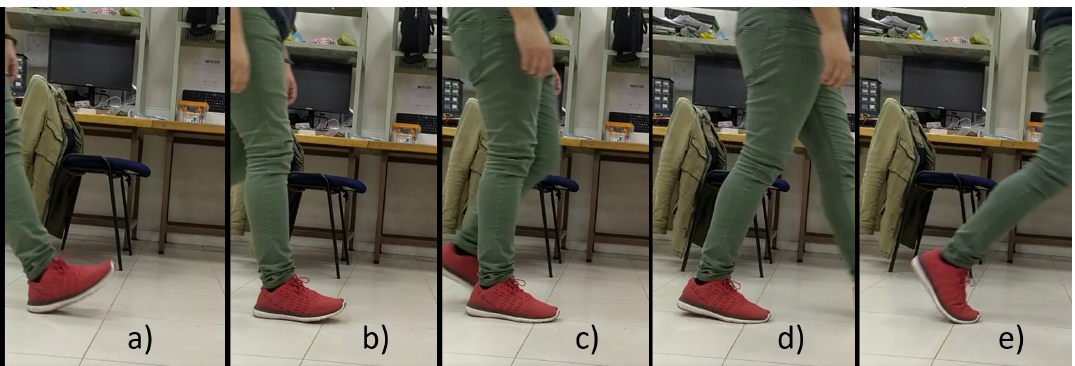
Figure 10. Moments of transition of detected subphases with the implemented algorithm for the foot with the red device. ( a ) Transition from swing phase to ICP. ( b ) Transition from ICP to FFCP. ( c ) Transition from FFCP to FFP. ( d ) Transition from FFP to FFPOP. ( e ) Transition from FFPOP to swing